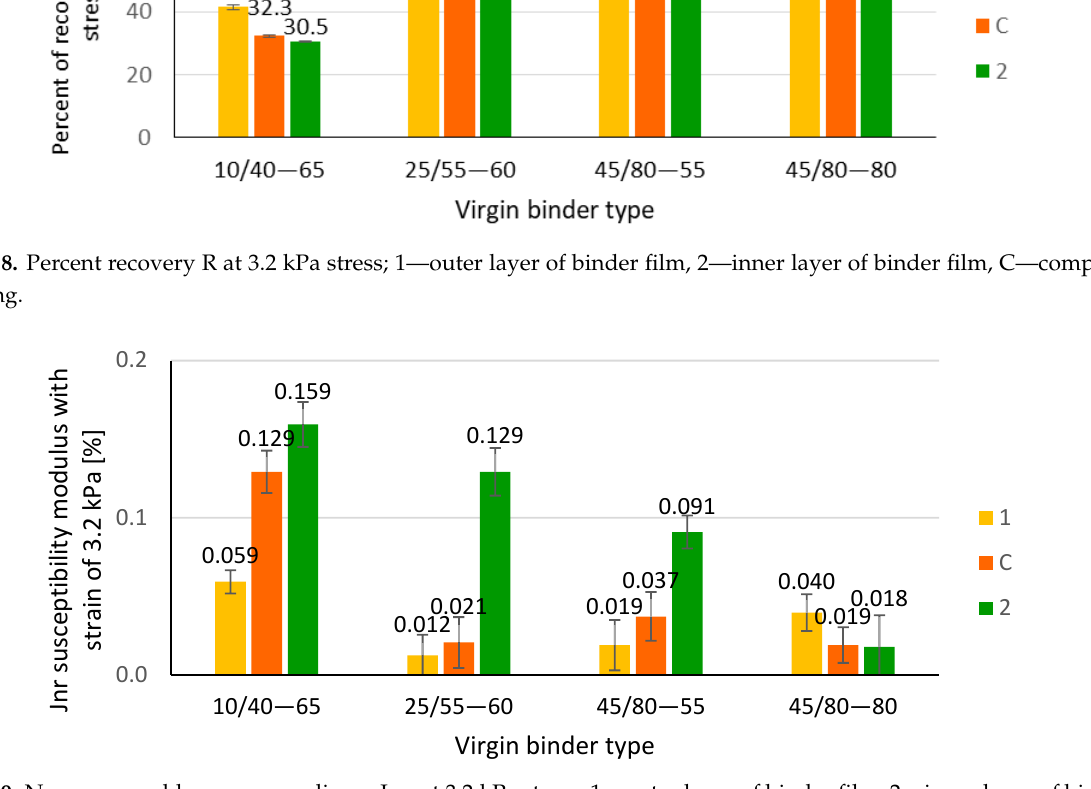
Figure 9. Non-recoverable creep compliance J NR at 3.2 kPa stress; 1—outer layer of binder film, 2—inner layer of binder film, C—complete blending. Table 8. Summary of the ANOVA analysis for the R 3,2 and J NR 3,2 parameters.